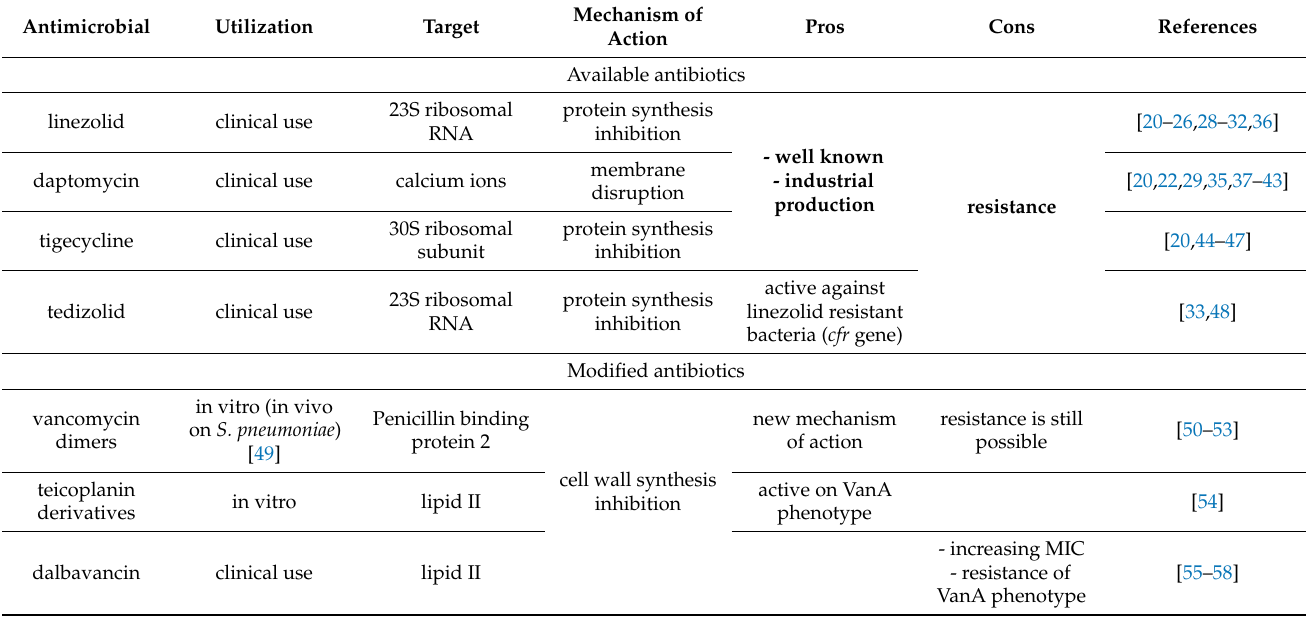
Figure 1. Mechanism of action of the different traditional and non-traditional strategies against vancomycin resistant Gram-positive pathogens. In bold, name of the molecule. Table 1. Sum up of the antimicrobials presented in this review. Bold text means that all the antimicrobials of the same type are concerned.